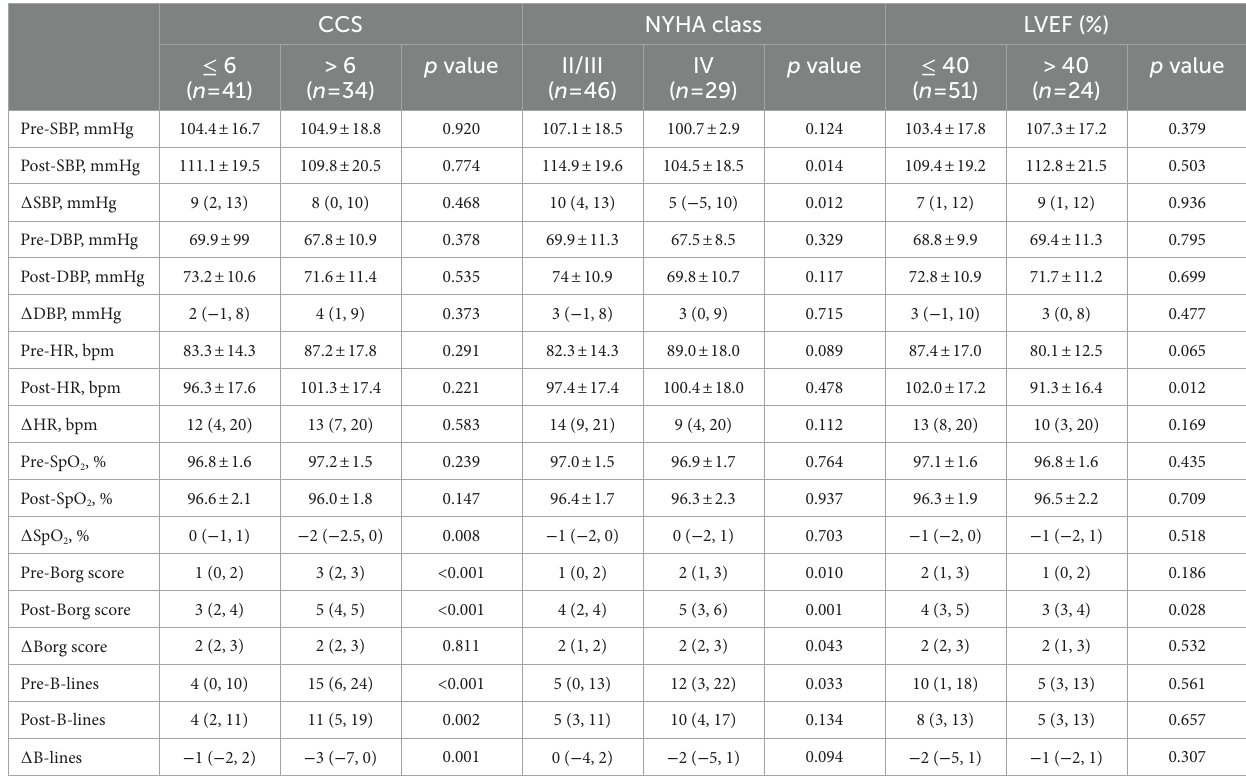
TABLE 3 Subgroup comparison of vital signs and